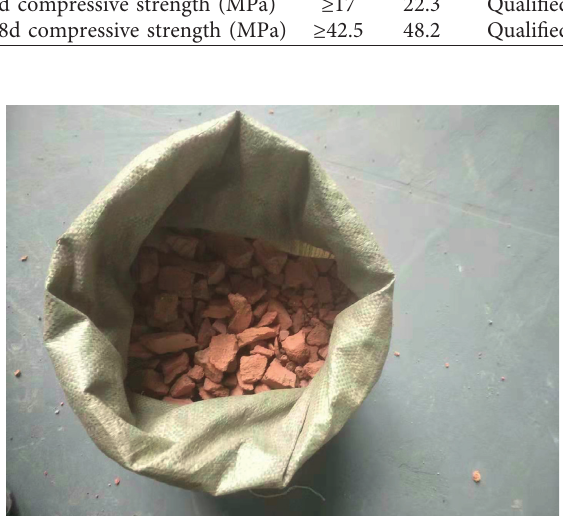
Figure 1: Waste clay bricks.